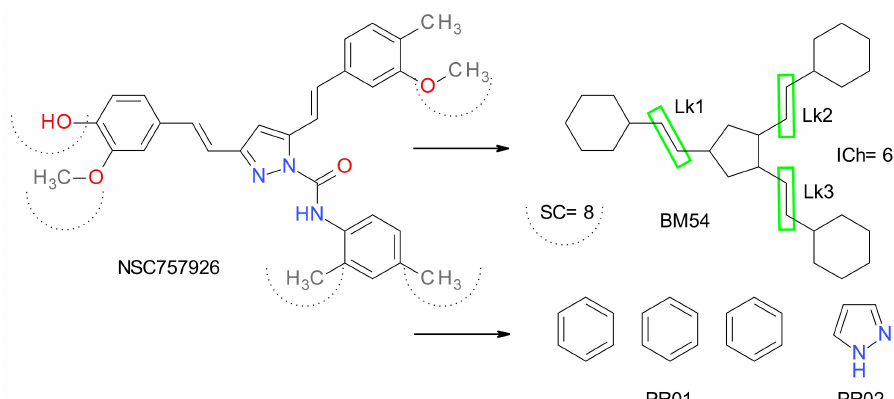
Figure 2. The transformation of the compound NSC757926 in the corresponding Bemis–Murcko (BM) skeleton and the extraction of its plain rings (PR). The Lk values represent the number of nodes that interconnect two ring fragments in the BM structure. The sum of Lk values is defined as the interior chain (ICh) variable. SC represents the number of non-hydrogen atoms in all the side chains.